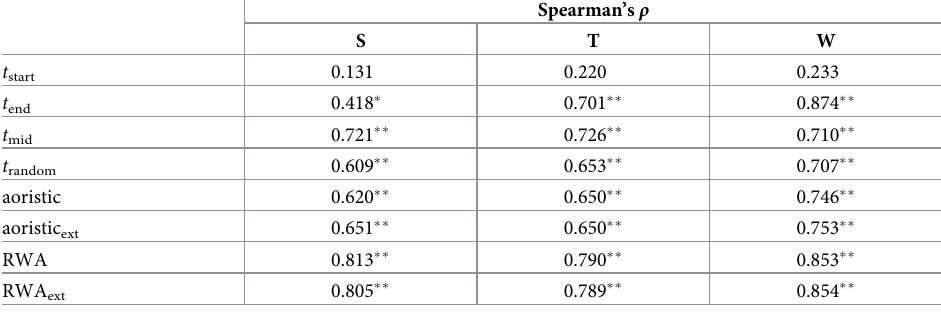
Table 3. Statistical results of comparing eight approximated offense times with exactly measured offense times by